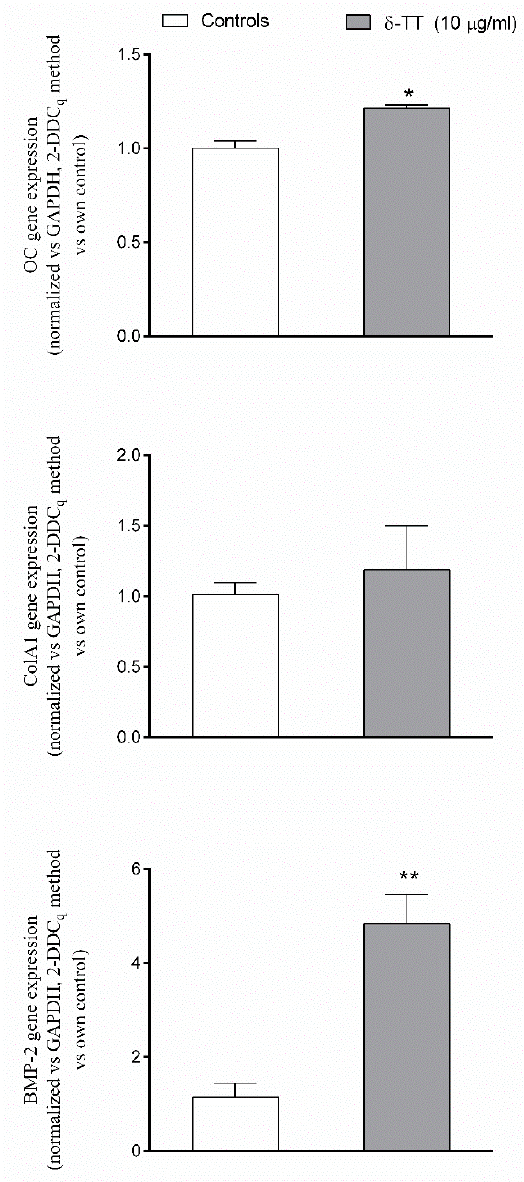
Figure 8. Effects of δ -TT (10 μ g/mL) on OC, ColA1 and BMP-2 expression measured by real-time PCR. mRNAs were collected 24 h after treatment with δ -TT. 10 ng of cDNA from each sample were amplified using the SYBR ® Green Chemistry and a specific set of primers for OC, ColA1, and BMP-2. Each sample was evaluated in triplicate. Data were normalized for GAPDH and expressed as mean ± SEM of the relative amounts of gene / GAPDH of each sample vs. the mean control value Five replicates were performed for each experimental point and the experiments were repeated twice. * p < 0.05; ** p < 0.01 vs. controls.